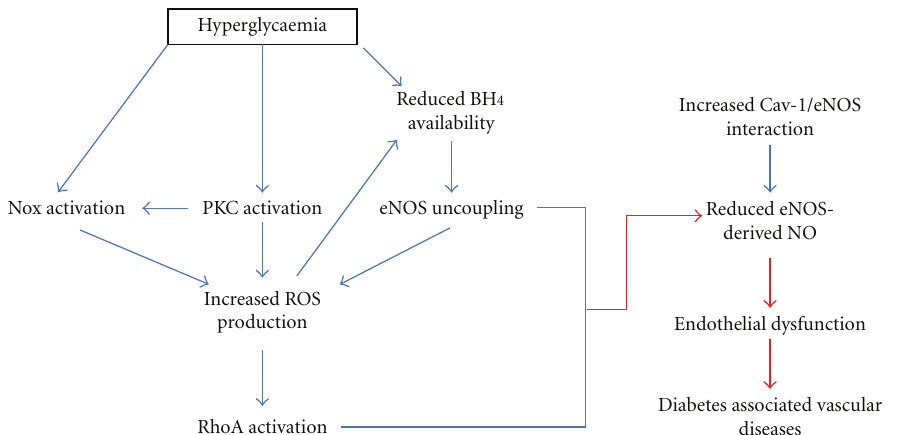
Figure 2: Pathways activated during hyperglycaemia that limit eNOS function and subsequent NO production, leading to endothelial dysfunction and diabetes-associated vascular